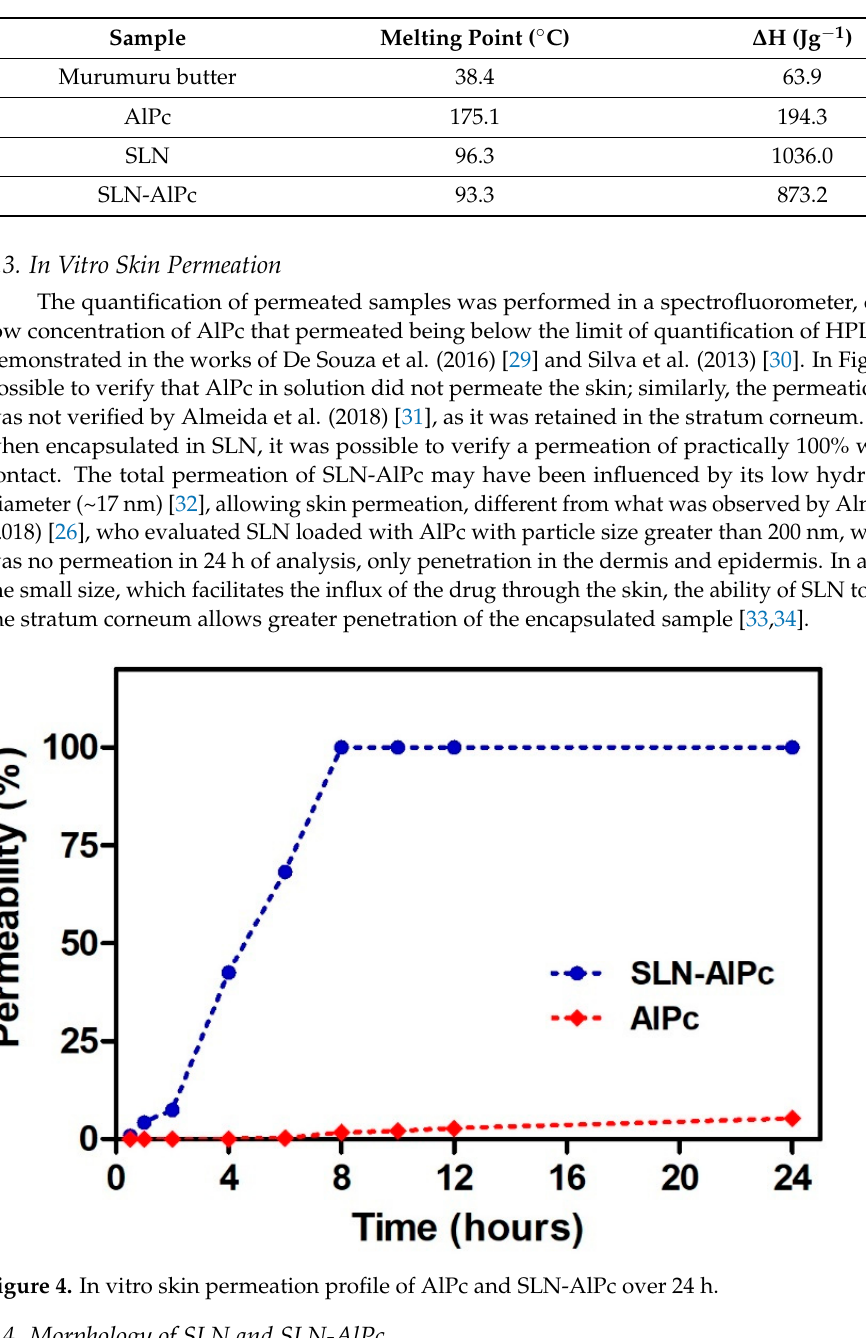
Figure 5. Transmission electron microscopy images of SLN-AlPc ( A , B ) and SLN ( C ). The micro- graphs show a spherical shape with small dark spots ( A , B ), suggesting the presence of AlPc. AlPc has a high affinity for osmium tetroxide, which explains the darker labeling. It is possible to observe that the SLN ( C ) presents a different morphology.